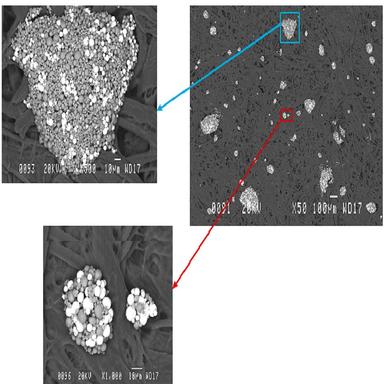
The Al-Ni atomized droplets being sprayed on filter paper. Note that the Inner tip size: 1.01 mm / Outer tip size: 1.52 mm, the feed rate of the suspension: 7.00 ml/min, the pressure of argon plasma gas: 50.00 PSI, and the carrier gas flow: 30.00 mm are the set of parameters employed to atomize the suspension and obtain the droplets.